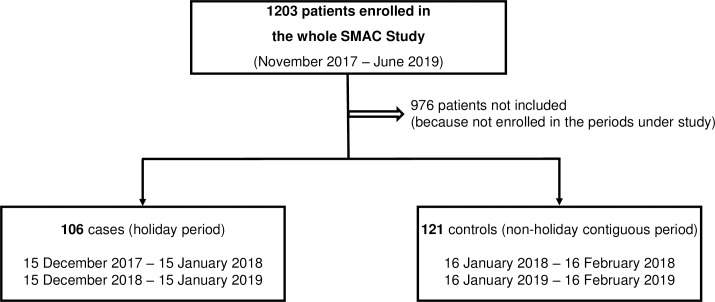
Flowchart of the study.As per protocol designs, two study populations were identified from all patients enrolled in the SMAC study. Patients enrolled in 32 consecutive days during the December holiday period (cases) and 32 consecutive, contiguous days during a non-holiday period (controls) were considered for the purpose of the study. Abbreviations: SMAC, San MAtteo Complexity.